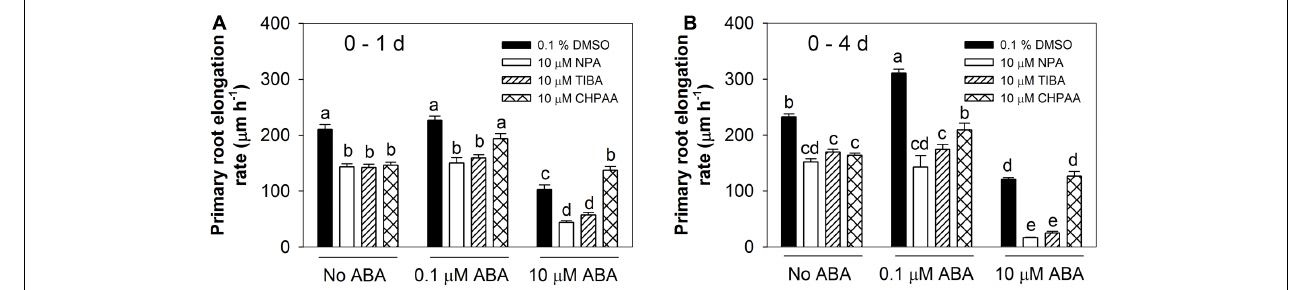
FIGURE 4 | Auxin influx and efflux inhibitors altered root responses to ABA. NPA, N -1-naphthylphthalamidic acid, auxin efflux inhibitor; TIBA, 2,3,5-triiodobenzoic acid, auxin efflux inhibitor; CHPAA, 3-chloro-4-hydroxyphenylacetic acid, auxin influx inhibitor. Primary root elongation rates (A) 1 day after treatment and (B) over a 4-day treatment period. Col-8 seedlings were germinated, chosen and transferred to medium as described in Figure 1 . The medium was treated with various ABA concentrations and 0.1% DMSO or 10 µ M NPA/TIBA/CHPAA. Primary root length was marked after transplanting and the increase of primary root were measured every day. The root elongation rate was calculated for 1 day and over a 4-day treatment on average. The values are means, and the vertical bars represent standard errors of the means. Data analysed using one-way ANOVA with Tukey’s post hoc test and different letters indicate significant differences cross all treatments at P < 0.05. Eta 2 : (A) 0.834; (B) 0.951. Seedling numbers: (A) n = 10–12; (B) n = 3–12. At least three independent experiments were performed and similar results obtained and